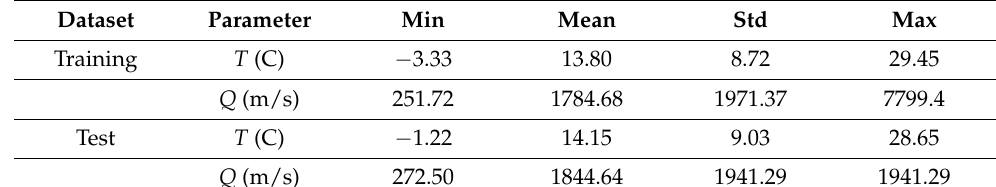
Table 1. The statistical parameters of the streamflow and temperature data.